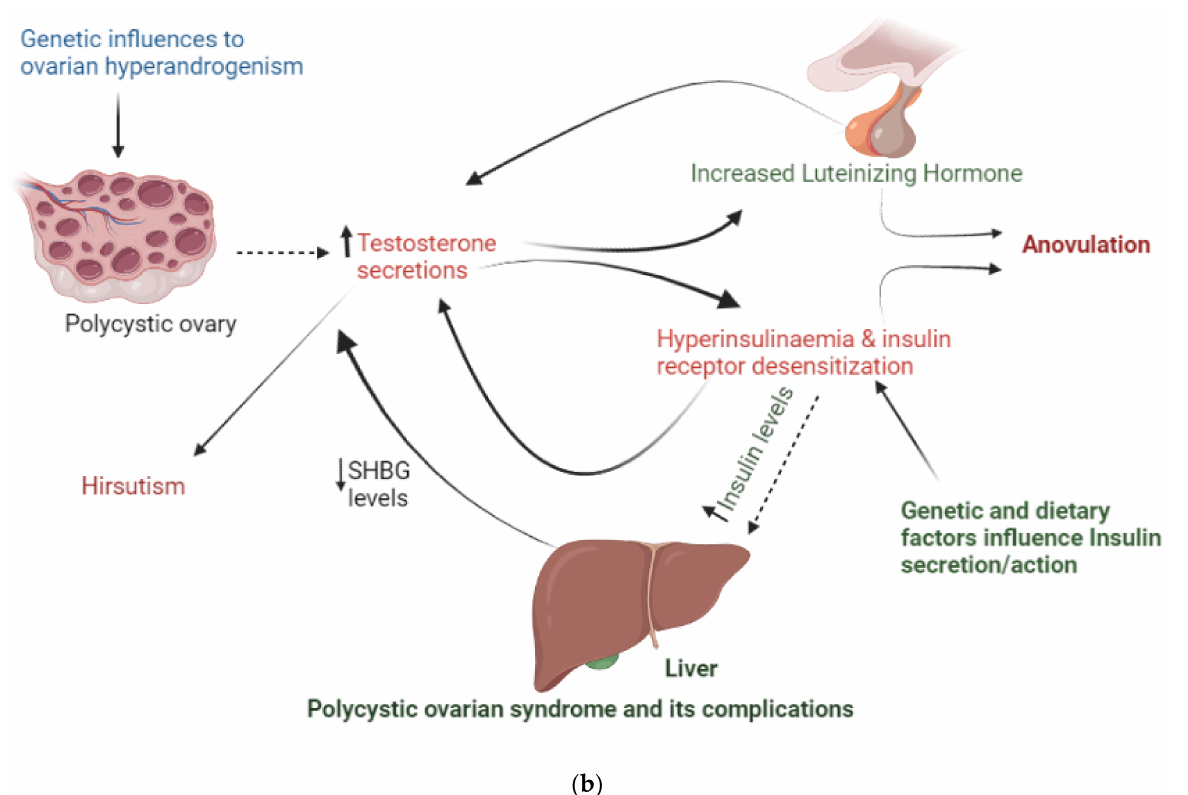
Figure 2. ( a ) Pathophysiologic features of polycystic ovary syndrome. PCOS is a multifactorial disorder that develops due to the combined effects of impaired genetic, epigenetic, and lifestyle factors. All these factors lead to disturbed pathophysiology (insulin resistance, hyperandrogenism, and low grade inflammation, which further result in complex symptoms of PCOS (Clinical, Re- productive, Metabolic, and Psychological). ( b ) Genetic influences and complications of polycystic ovarian syndrome. Different genetic polymorphism influences the pathophysiology of PCOS. Genetic influence alters different hormonal levels—androgen, insulin, AMH, SHBG, LH, FSH, testosterone, and different other hormonal levels, which further contribute to disease